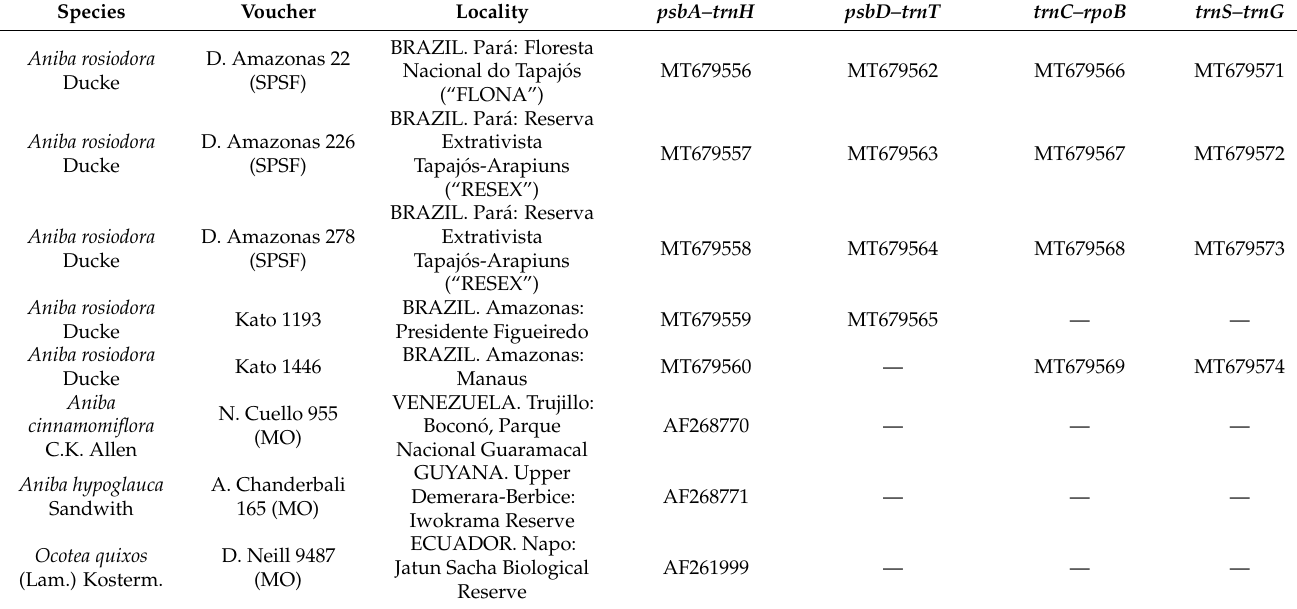
Table 2. List of accessions included in the phylogeny analysis in this study, with voucher information (collector followed by code), collection locality, and GenBank accession numbers. Dashes indicate that no sequences were